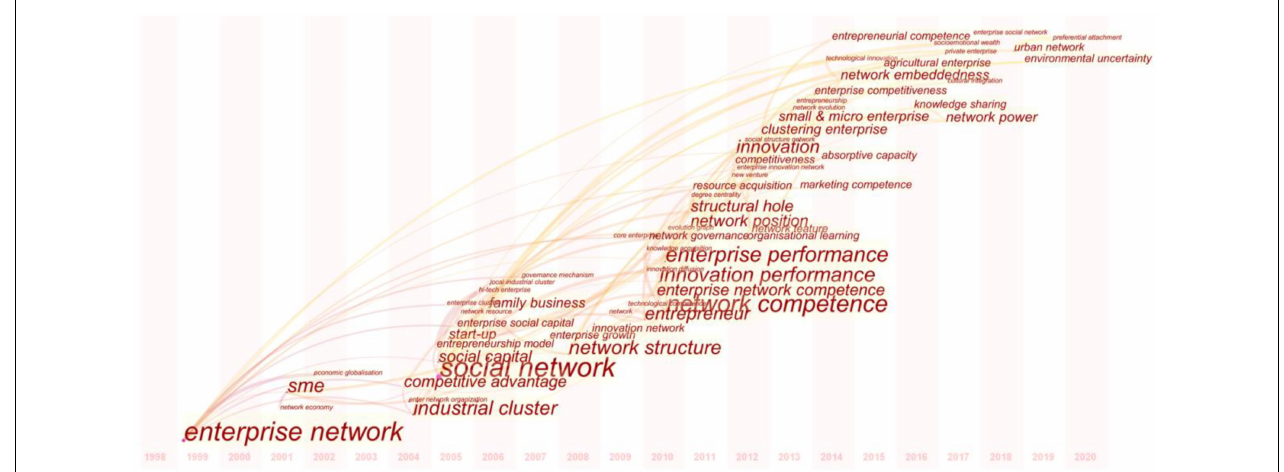
FIGURE 6 | Temporal knowledge map of high-frequency